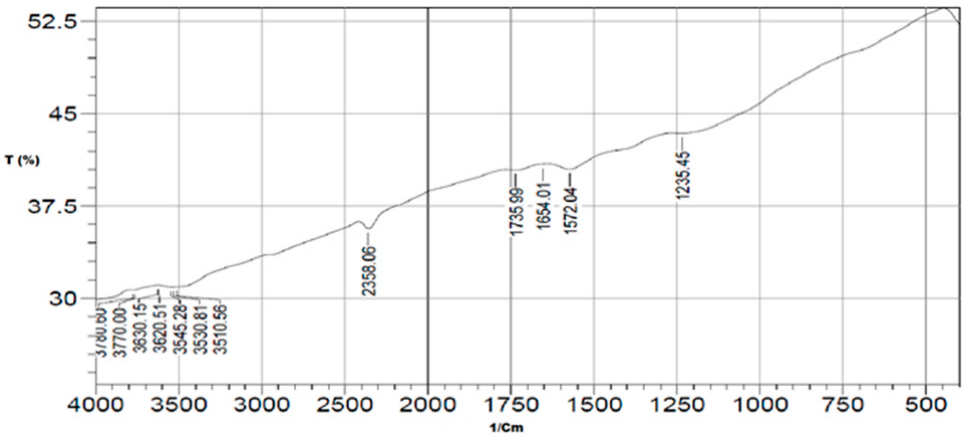
Figure 1. FTIR pattern of MWCNTs.